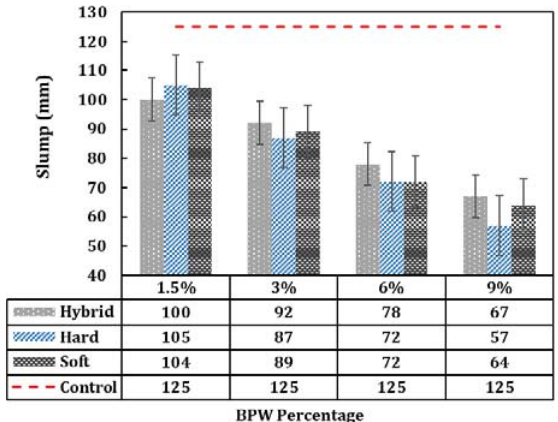
Figure 4. Slump test results.